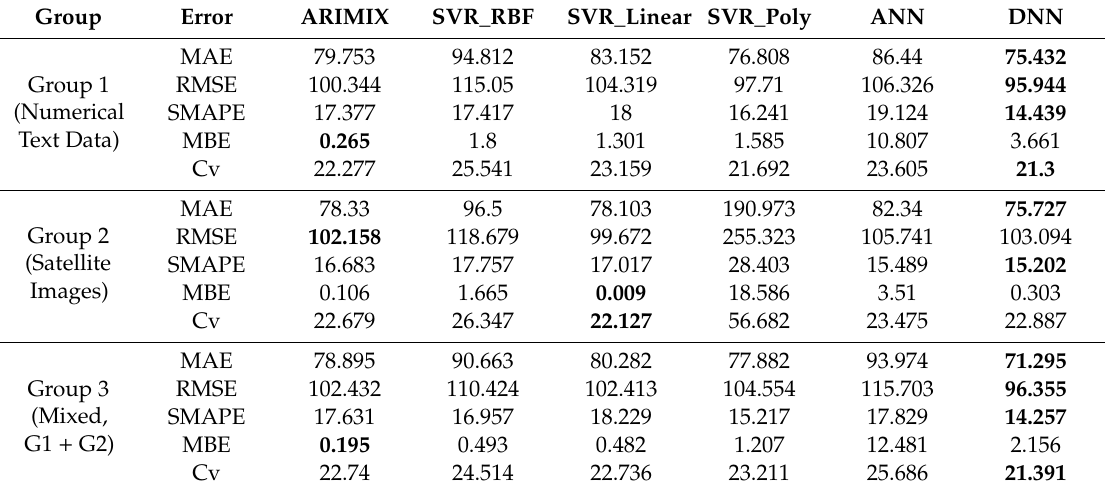
Table 11. Solar PV generation prediction result of case 2.